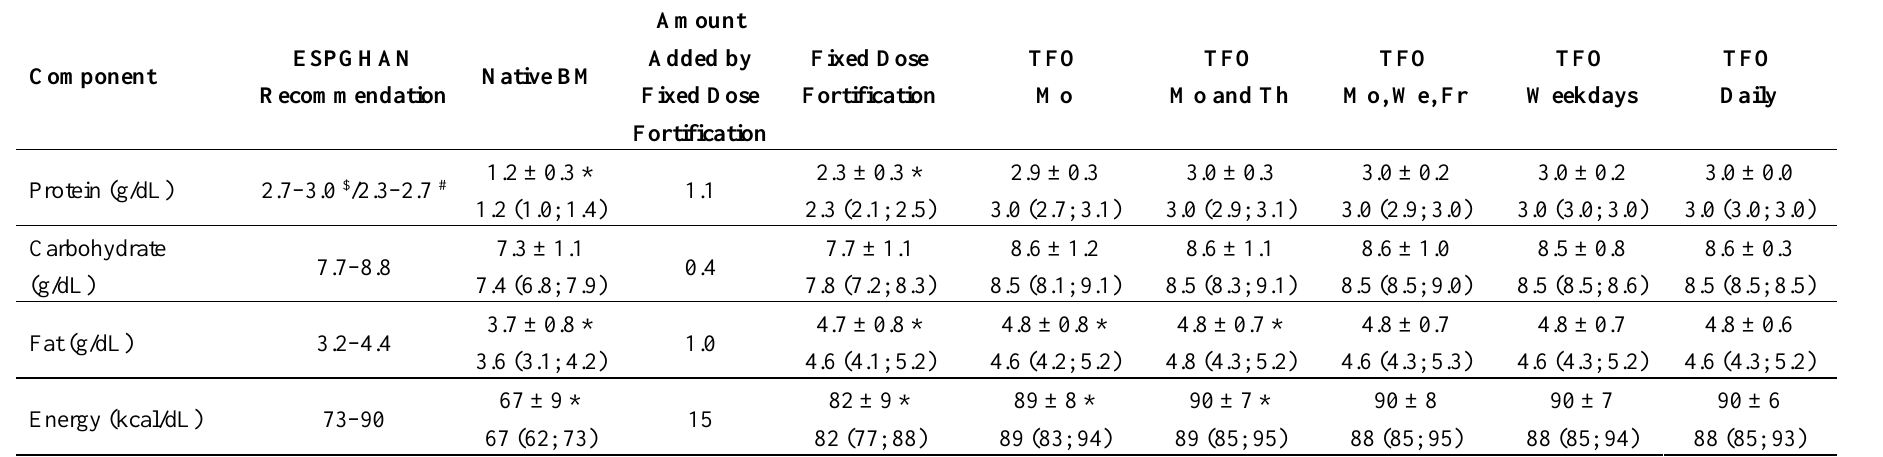
Table 1. Protein, carbohydrate, fat and energy of native breast milk (BM), fixed dose fortified BM and target fortified BM (TFO) for measurements of macronutrients done on different